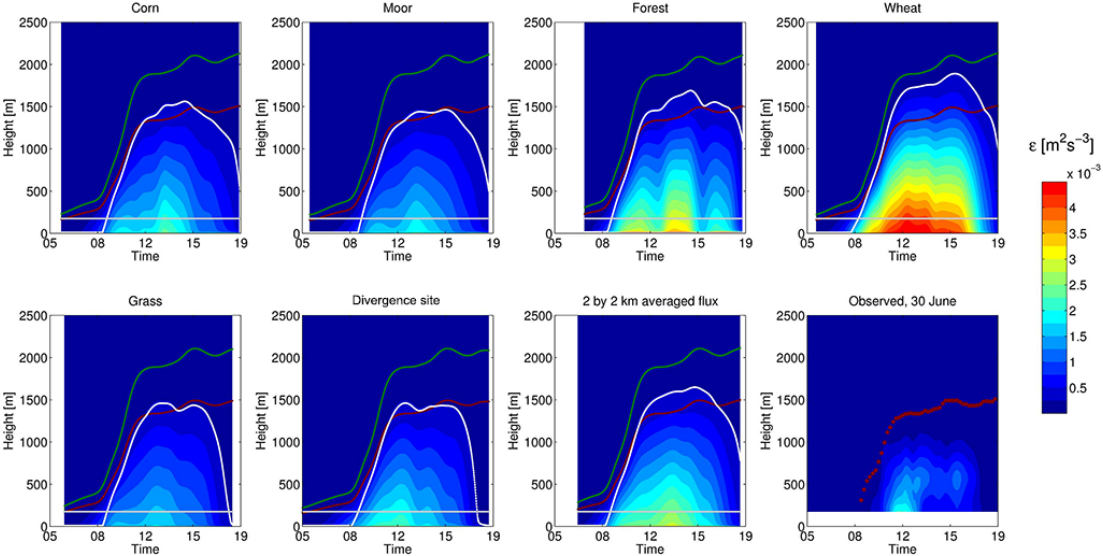
Figure 11. Modeled boundary layer dissipation rate for 30 June for six simulations over different surfaces with available near-surface measurements during the BLLAST field campaign, as well as a simulation driven by a 2km × 2km averaged flux. The lower right panel shows the observed dissipation rate from the UHF wind profiler between 175 and 2000m. The red line or dots indicate model and observed boundary layer depth, the green line indicates the model height of no turbulence, and an isoline for TKE equal to 0.3m 2 s − 2 is included as a white line. A horizontal gray line is also included at 175m to show the lowest level available from the UHF wind